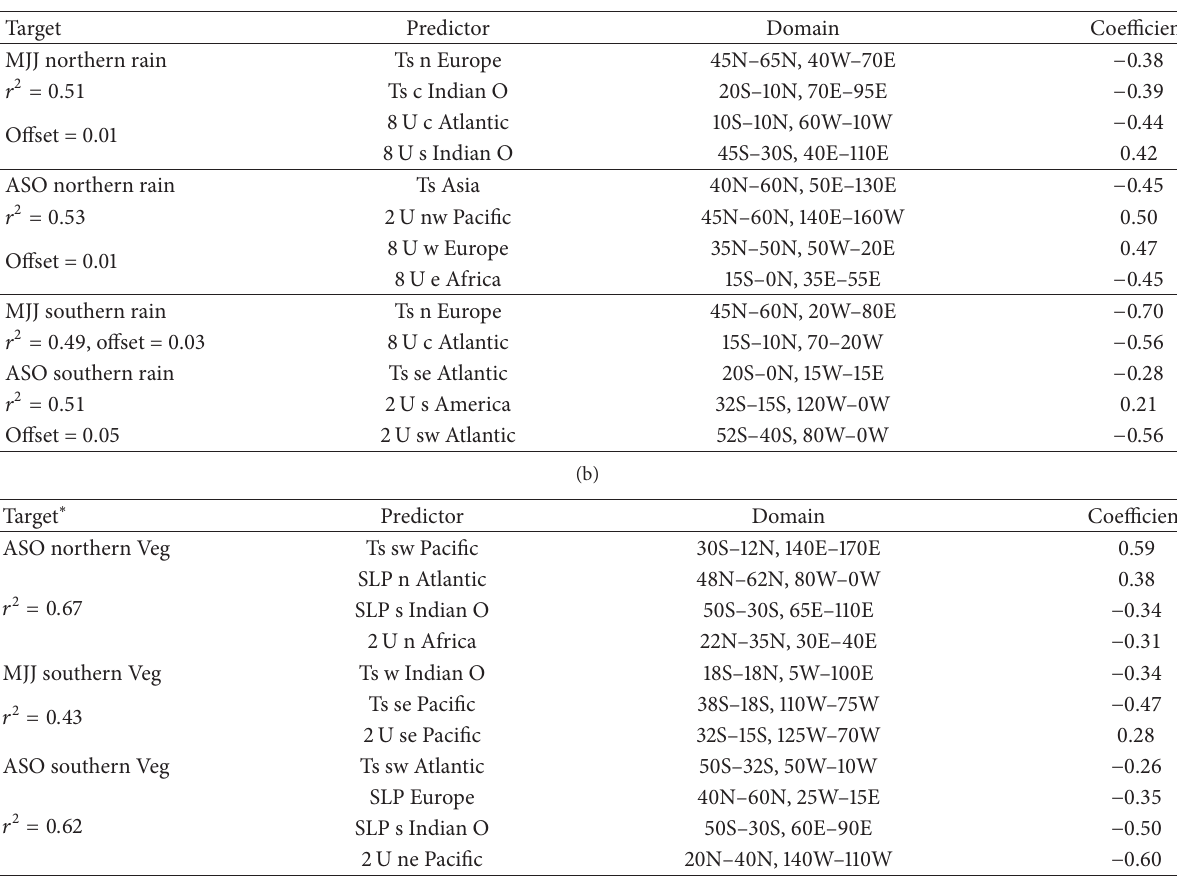
Table 1: Multivariate predictors for (a) rain and (b)